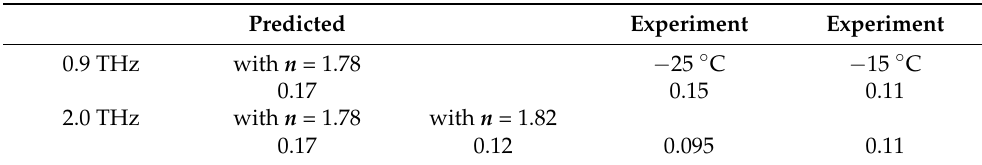
Figure 4. Raw data, spectral reflected signal intensity for water and ice. ( a ) Reflected signal intensity of water and ice at different temperatures in arbitrary units. Ice samples were made in situ. Each of the 10 data points is an average of 50 scans per measurement. ( b ) Reflected signal intensity (normalised to that of air, n = 1) at different temperatures. The two high sensitivity spectral bands centered around 0.9 and 2 THz are shown. Table 4. Comparison of reflected signal intensity of the experimental data from water and ice to theoretical predictions (cid:1) *. Predicted Experiment with n = 1.78